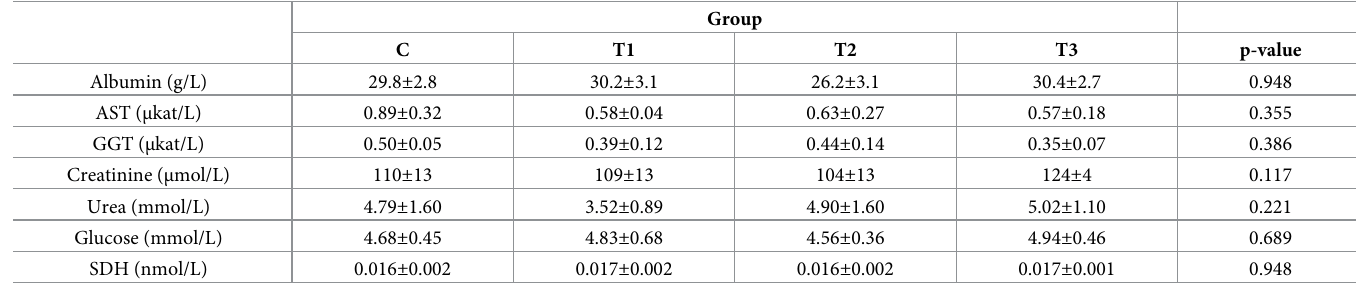
Table 9. Biochemical